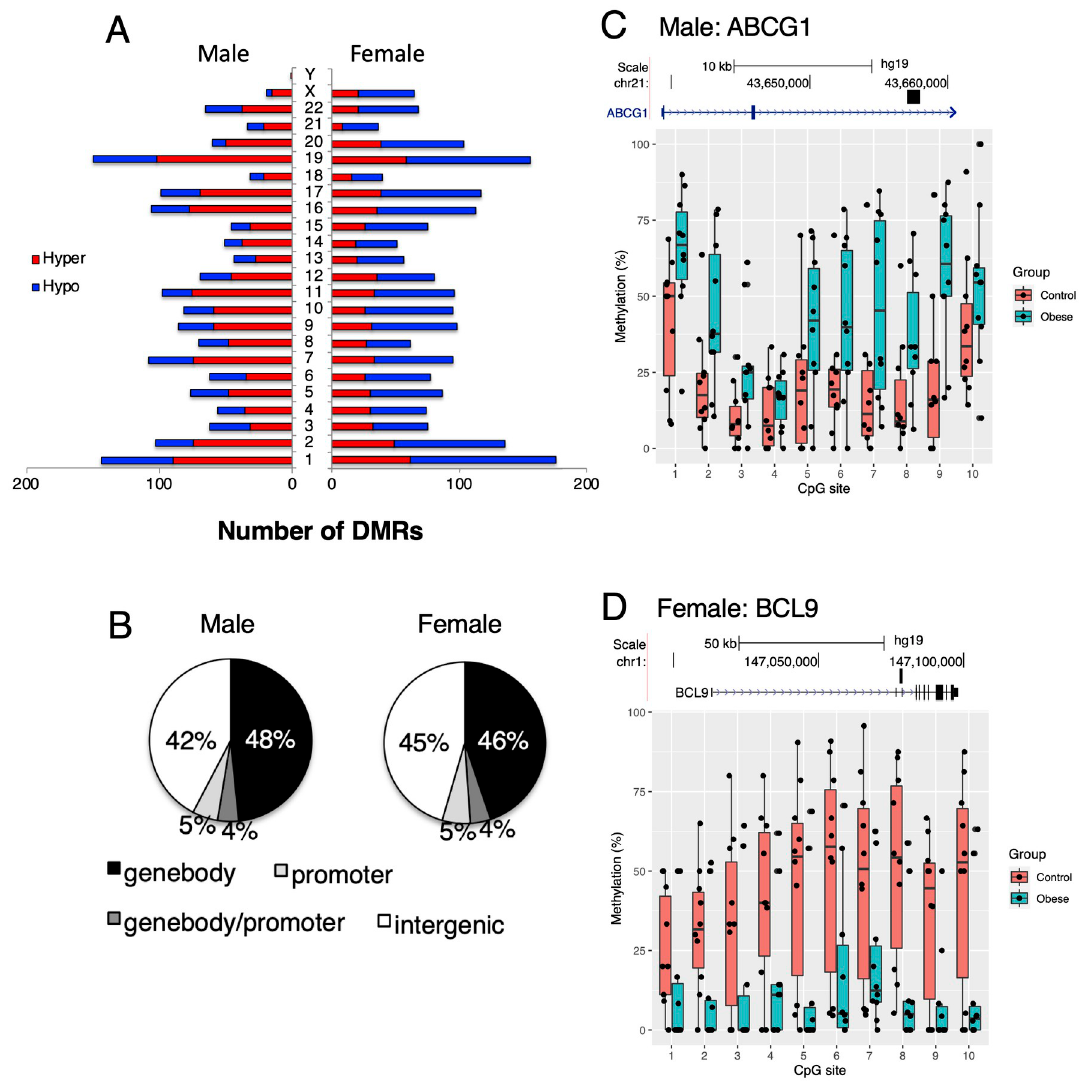
Fig 2. Overview of differentially methylated regions in the OBS discovery cohort. (A) Number of DMRs in relation to chromosomal locations that are either hypermethylated (red) or hypomethylated (blue) in male and female neonates born to mothers with obesity compared to controls. (B) Proportion of DMRs in relation to genetic regions. (C) Representative top DMR in male neonates on the ABCG1 gene showing methylation percentage in individual CpG sites within the DMR. (D) Representative top DMR in female neonates on the BCL9 gene showing methylation percentage in individual CpG sites within the DMR. The genomic track shows the gene location starting from the first exon and the DMR location. Hypermethylation refers to greater DNA methylation among neonates from mothers with obesity compared to neonates from mothers with a normal BMI. Hypomethylation refers to lesser DNA methylation among neonates from mothers with obesity compared to neonates from mothers with a normal